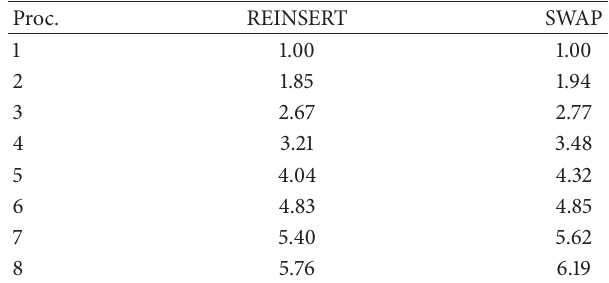
Table 2: DLS speed-up: balanced start. Proc.